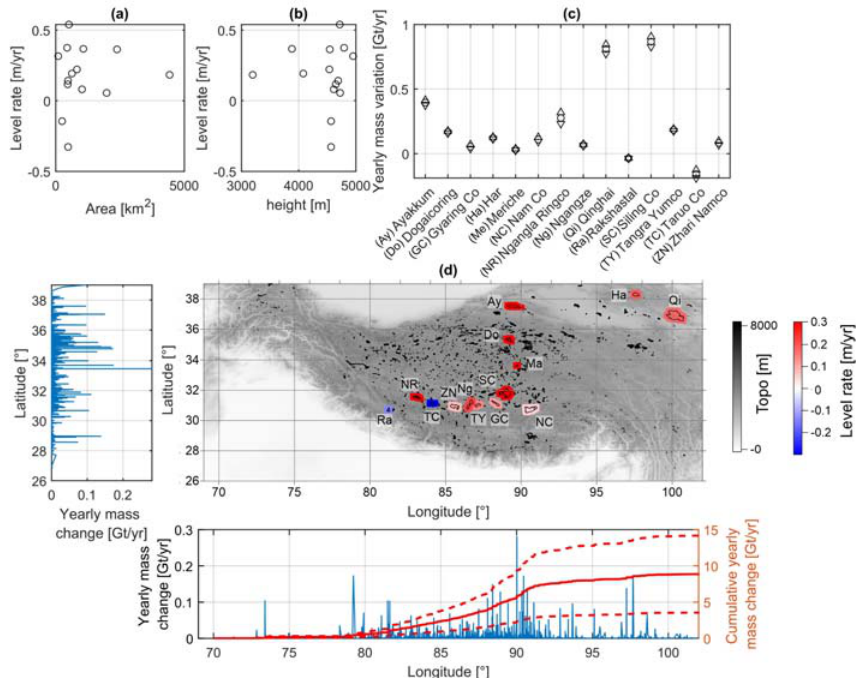
Figure 6. Level variations for 14 lakes in Tibet: ( a ) level rates as function of the lake area; ( b ) level rates as function of the lake average height; ( c ) yearly mass variations for lakes in Tibet (circle) and uncertainty on mass rate derived from confidence interval on fitting the time-series rates. ( d ) Spatial distribution of lakes (black outlines); the 14 lakes of the DAHITI database are also labelled. For